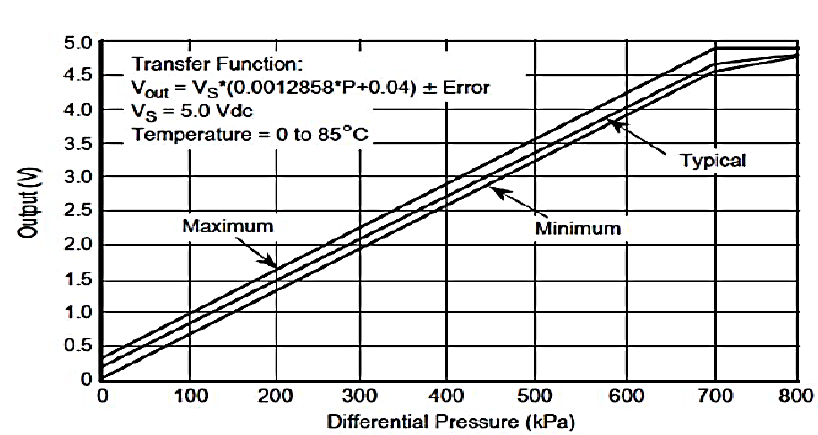
Figure A4. Voltage vs. differential pressure transfer function [9].